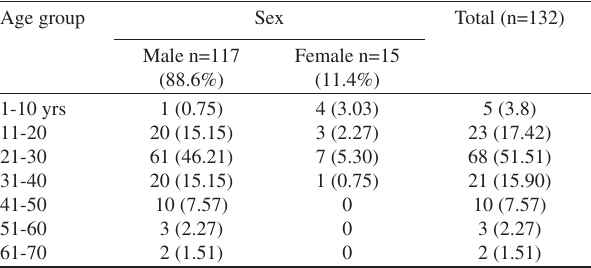
Table 1 - Age and sex distribution of patients with maxil- lofacial